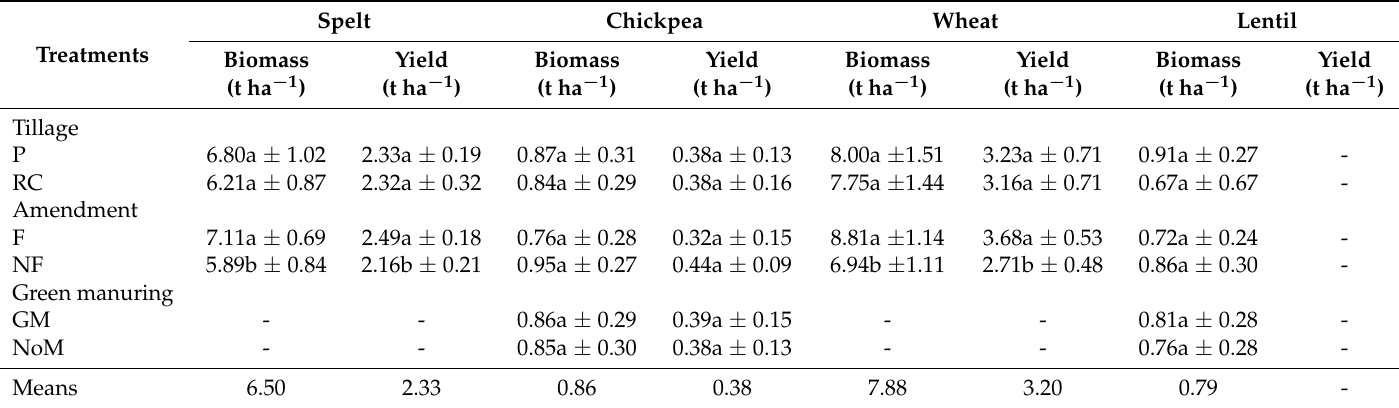
Table 3. Cash crops’ biomass and yield (except for the lentil crop). Means ( ± Std Dev) are presented under different tillage systems, organic amendments, and green manuring strategies (P: conventional plough; RC: reduced chisel; F: composted farmyard manure; NF: unfertilized control; GM: green manure; NoM: no green